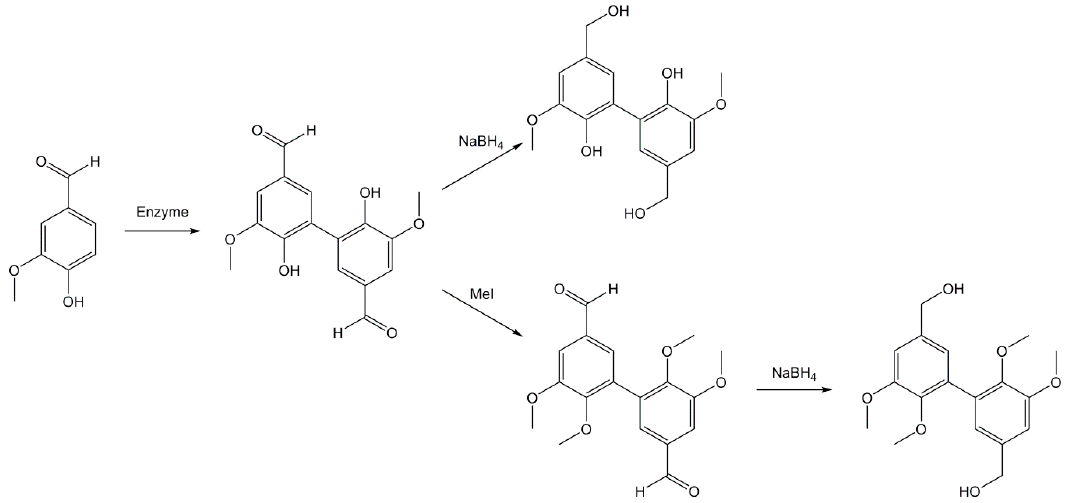
Scheme 10. Synthetic pathway developed by Grelier et al. [156] to obtain diphenolic derivatives from